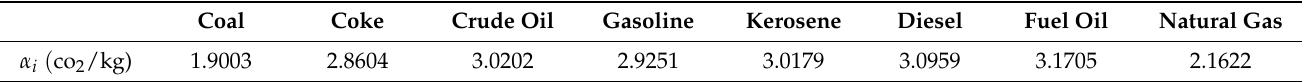
Table 2. Conversion coefficients of CO 2 emissions for various energy sources (IPCC National Green- house Gas Emissions Inventory, 2006